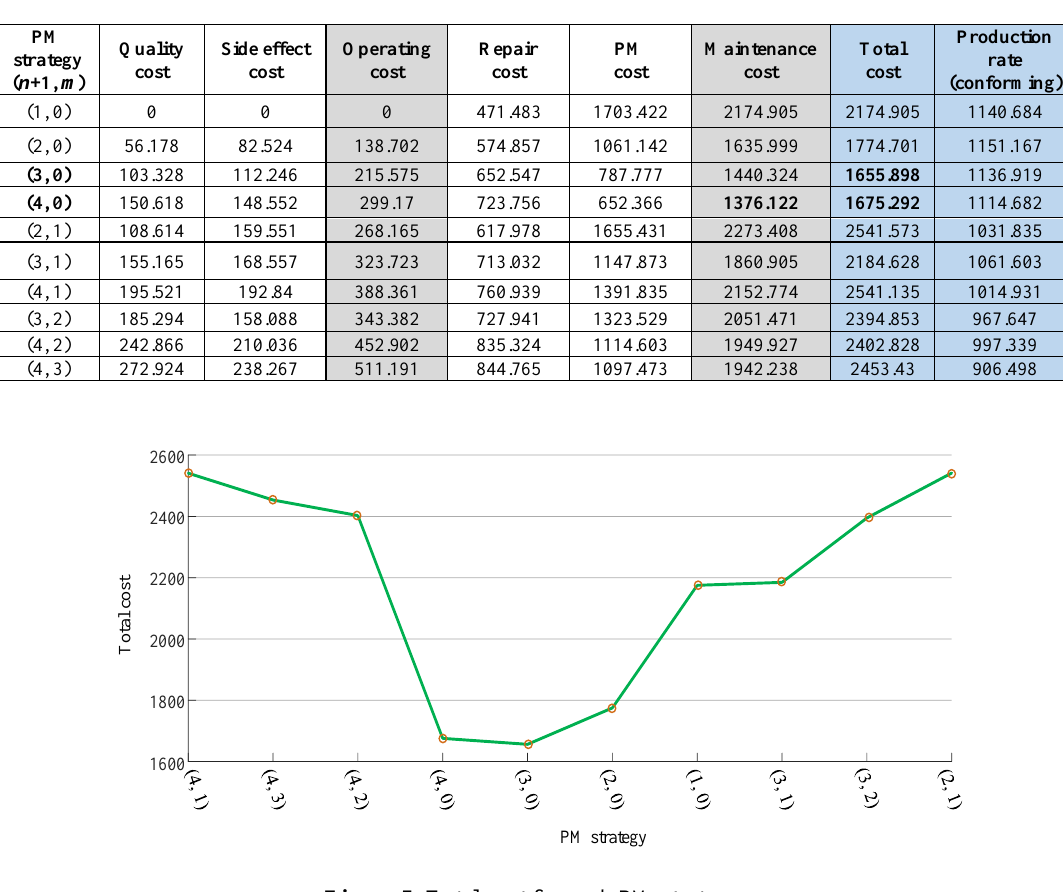
Figure 5. Total cost for each PM